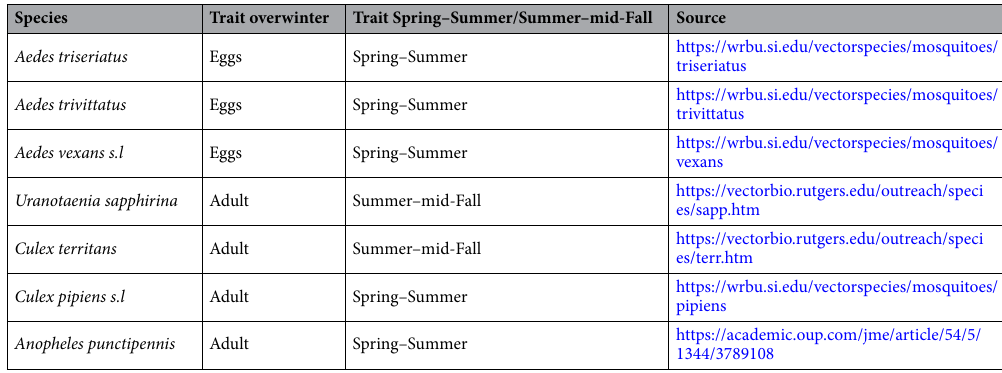
Table 1. Species included in analyses with trait classifications including overwintering stage, and timing of peak abundance in adult stage with “Spring–Summer occurring prior to August 4th each year and “Summer– mid-Fall” occurring after August 4th; bimodal flight patterns are classified as “Spring–Summer.”